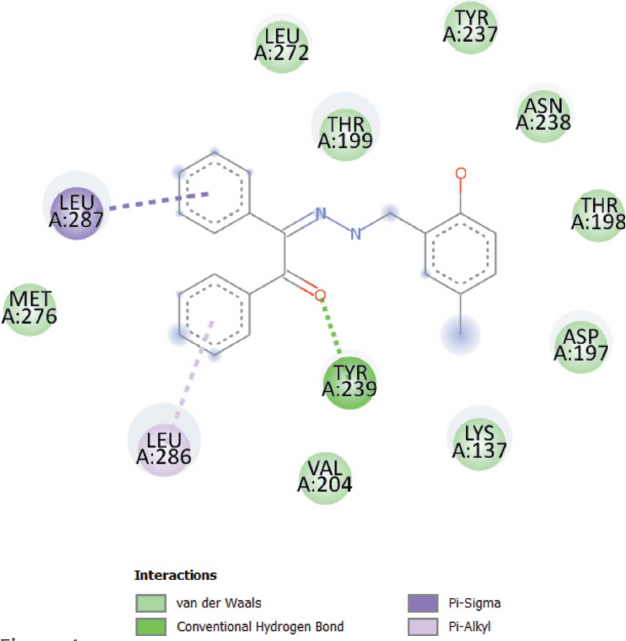
Figure 4 Two-dimensional visuals of the intermolecular interactions for the best binding pose of the title compound docking with